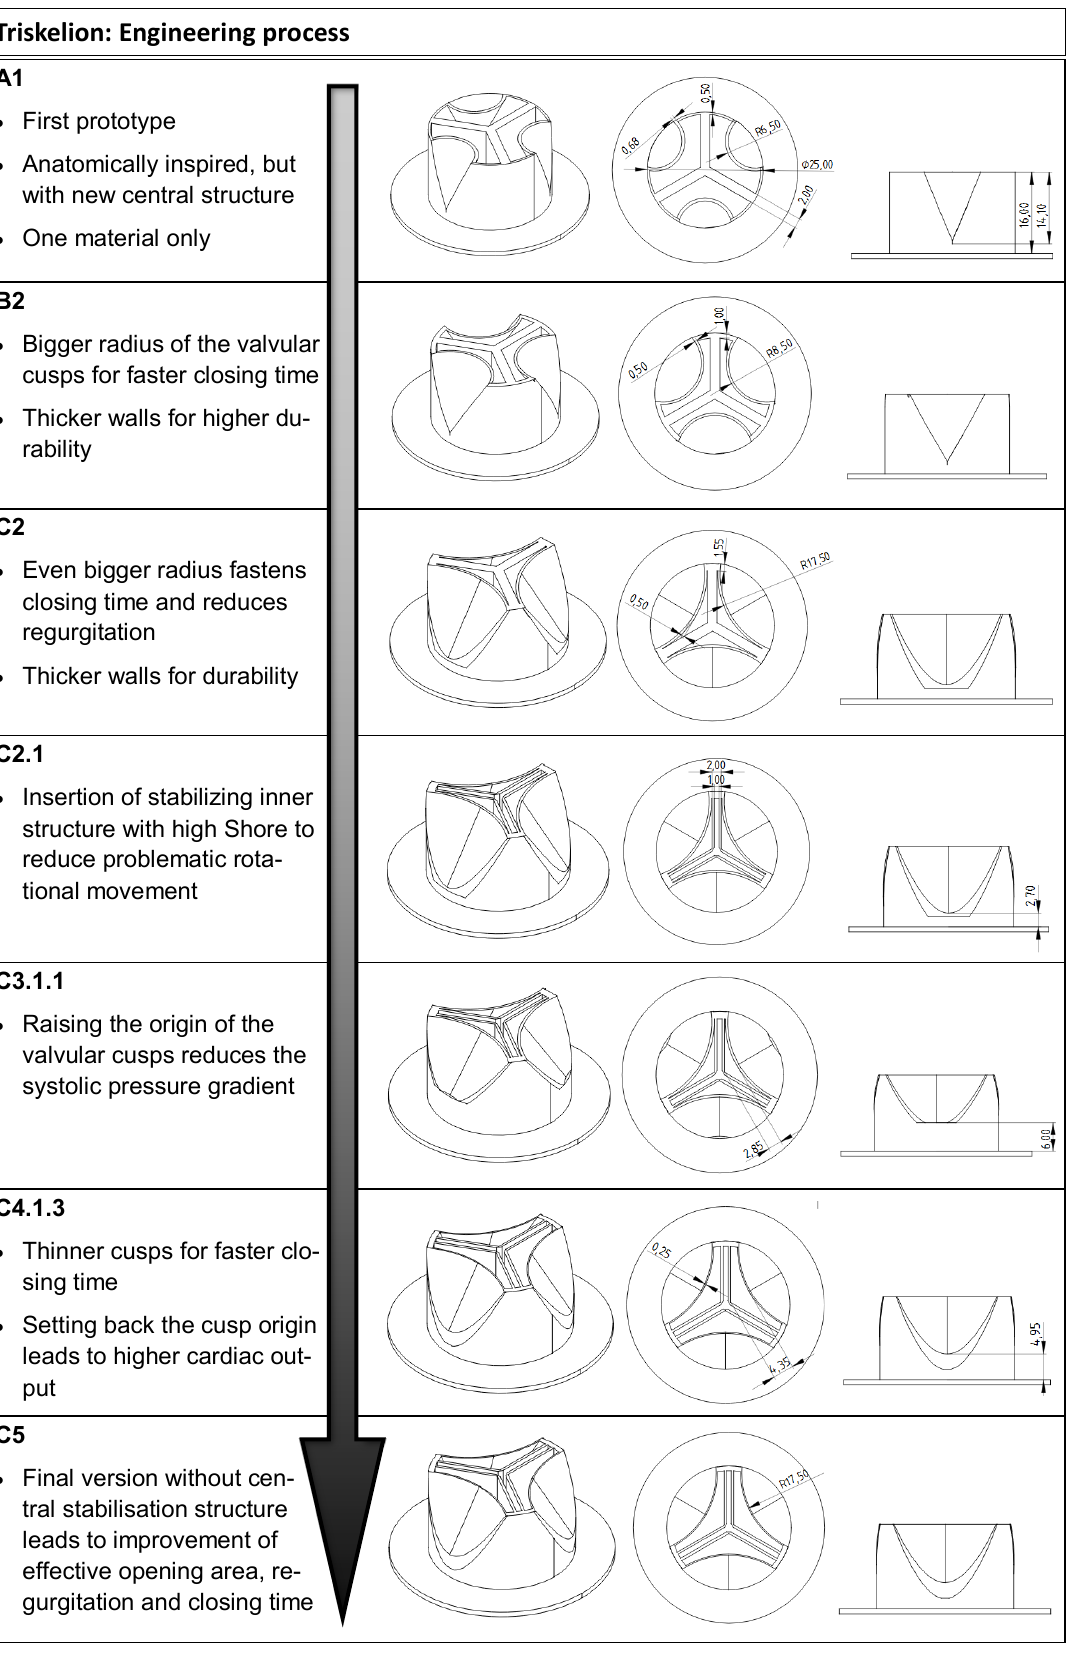
Figure 2. Engineering